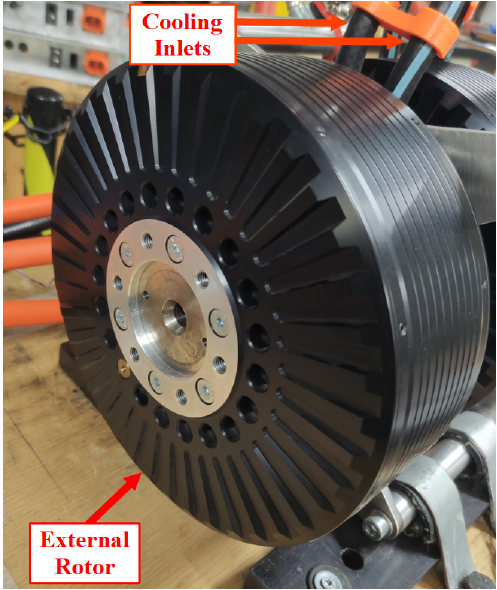
Figure 8. EMRAX 228 Low Voltage Liquid